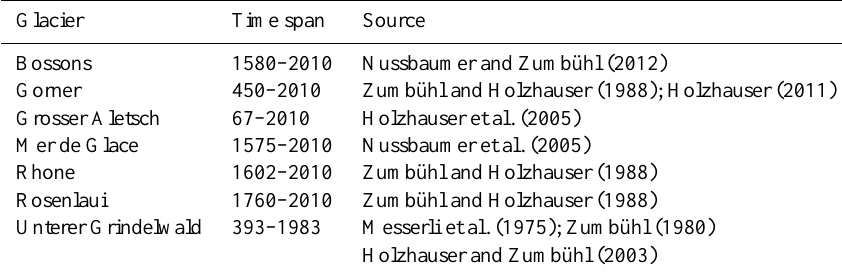
Table 1. Sources of glacier length change data used in this